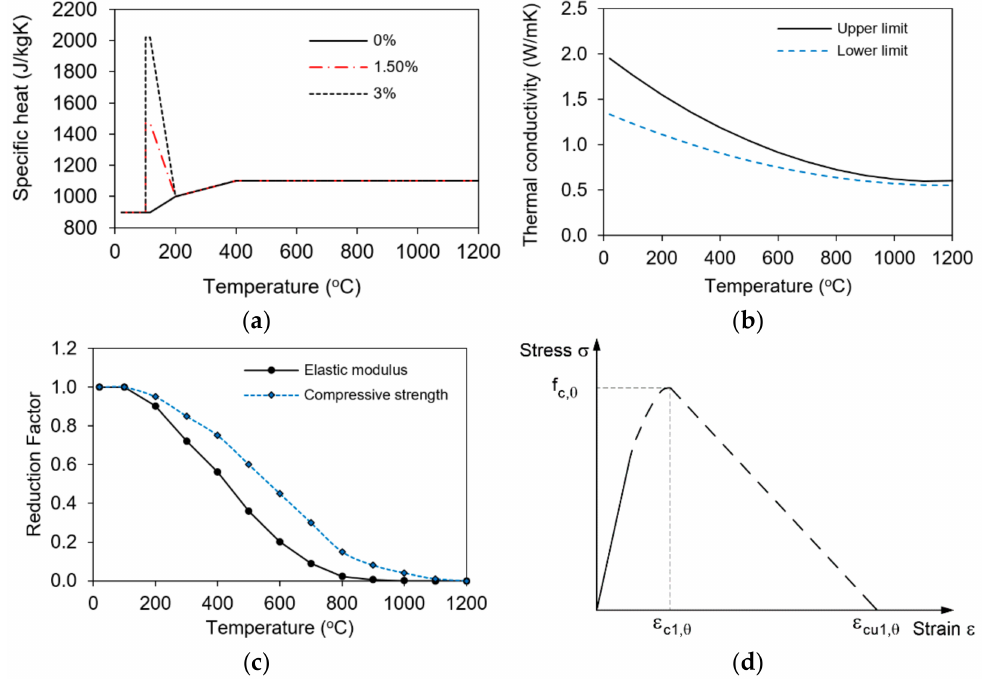
Figure 5. Material properties of concrete at high temperature: ( a ) Specific heat; ( b ) Thermal conduc- tivity; ( c ) Strength and stiffness reduction factor; ( d ) Stress-strain curve at elevated